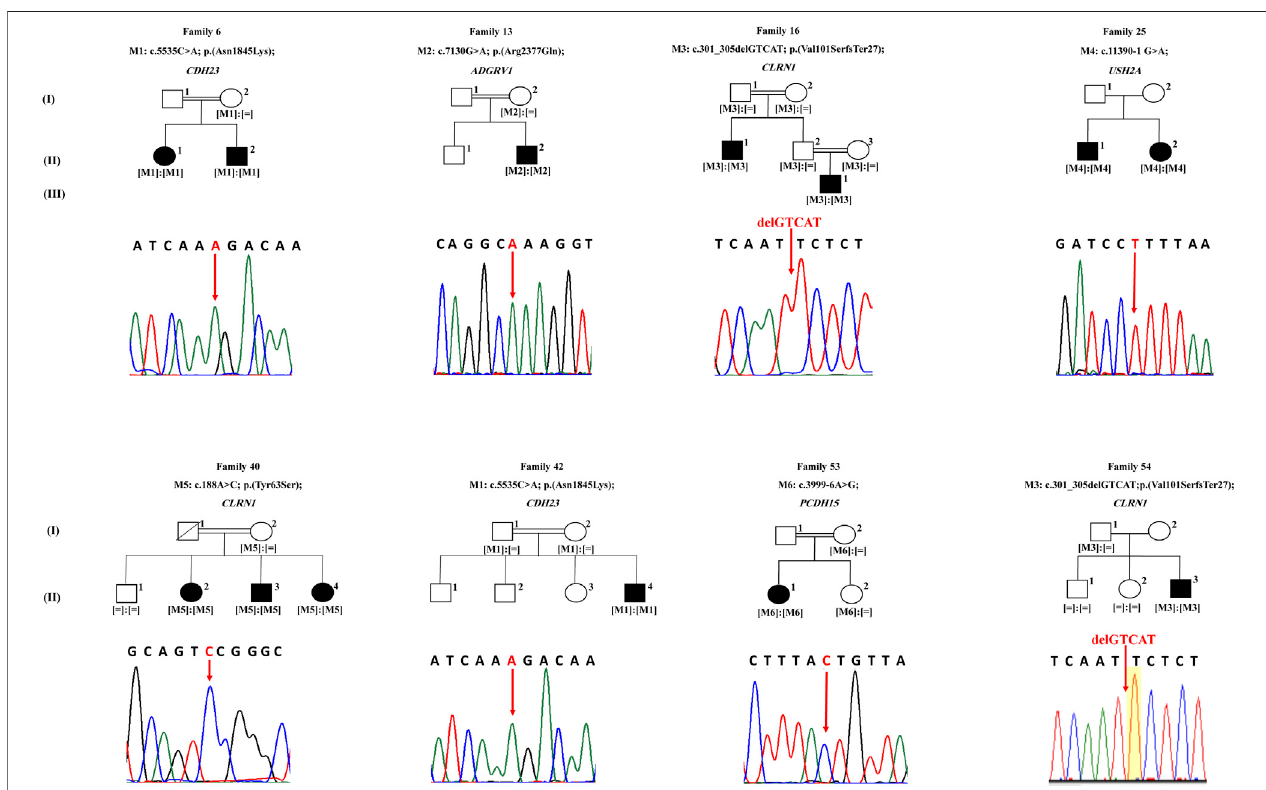
FIGURE 1 | Pedigrees of eight families with Usher syndrome. Sequencing results of each proband are shown under the corresponding pedigree, noting that sequences of probands of families 25 and 53 are in reverse direction. White symbols indicate unaffected members. Black symbols indicate affected members. Square and round symbols represent male and female individuals, respectively. The slash indicates deceased individuals. Double horizontal lines represent consanguineous unions. [M] de fi nes mutated alleles. [ = ] de fi nes wild type